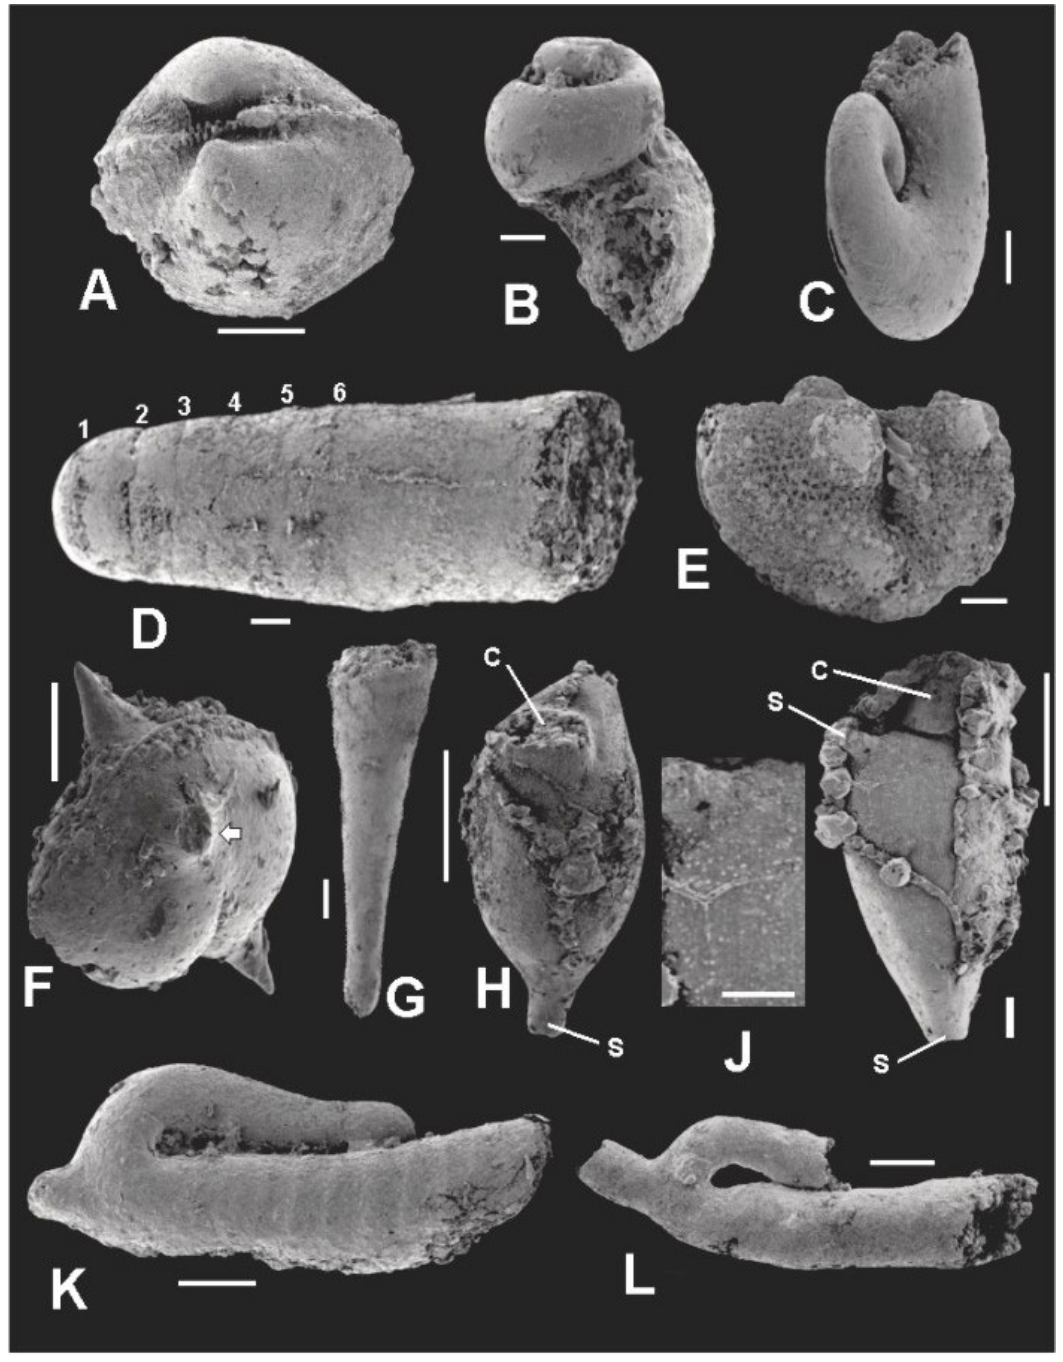
Figure 13. SEM images of microorganisms co-occurring with the microflora. Scale bar in J = 40 µm. All other scale bars = 100 µm. ( A ) TYSV-01; paleotaxodont bivalve, probably Nuculoidea corbuliformis ; ( B ) TYSG-01; highspired loxonematacean gastropod, possibly Palaeozygopleura sp.; ( C ) TYSG-02; Euomphalacean gastropod, possibly Euomphalus sp.; ( D ) TYSC-01; Longiconic nautiloid. Numbers identify the positions of the first six septa; ( E ) TYSO-01; ostracode, probably Ulrichia sp.; ( F ) TYSO-02; spiny ostracode, probably belonging to either to the Aechminidae or Aechminellidae. White arrow points to the base of a broken lateral spine; ( G ) TYSD-01; Dacryoconarid, probably Viriatellina sp.; ( H , I ) TYSZ-01; TYSZ-02; ctenostome bryozoan zooids. c—collar; s—stolon; ( J ) enlargement of area at base of lateral stolon in I; ( K ) TYSJ-01; Jinonicella kolebabi , ribbed morph; ( L ) TYSJ-02; Jinonicella kolebabi , unribbed morph.